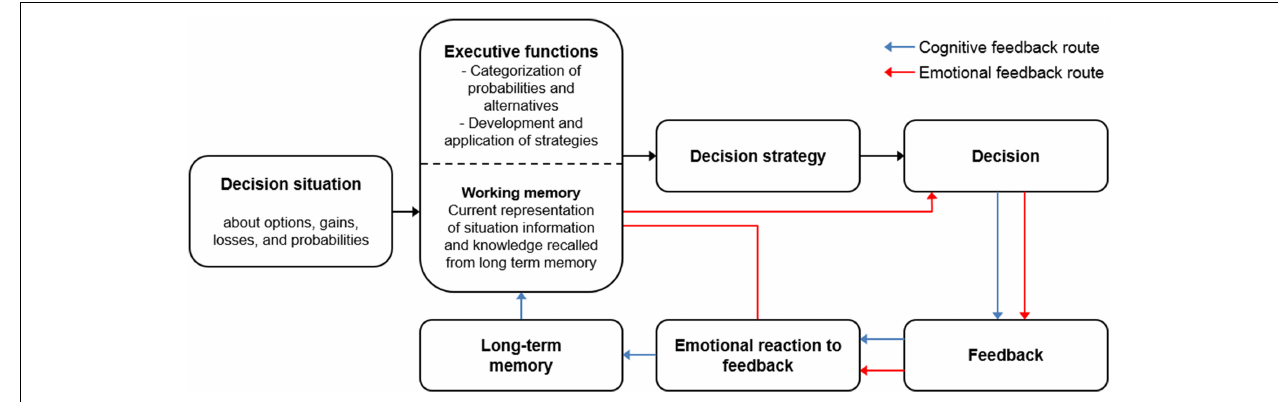
FIGURE 1 | The model of decision making under risk. A major role of executive functions is suggested for the development and application of decision-making strategies as well as for processing of